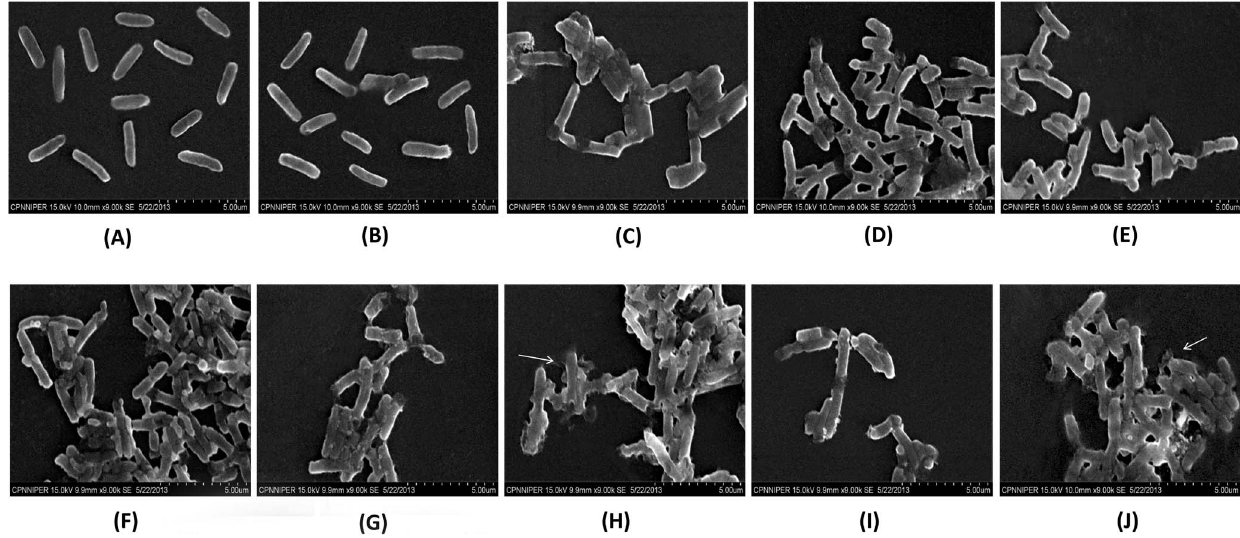
Figure 3. Scanning electron micrographs of Salmonellaenterica serovar Typhimurium after 2 hours in presence of (A) normal saline (B) nisin (100 m g/ml) (C) EDTA (7.5 mM) (D) nisin (20 m g/ml) + EDTA (20 mM) (E) ampicillin (0.25 m g/ml) (F) nisin (100 m g/ml) + ampicillin (0.5 m g/ml) (G) ceftriaxone (3 m g/ml) (H) nisin (4 m g/ml) + ceftriaxone (0.75 m g/ml) (I) cefotaxime (2 m g/ml) (J) nisin (5 m g/ ml) + cefotaxime (1 m g/ml).